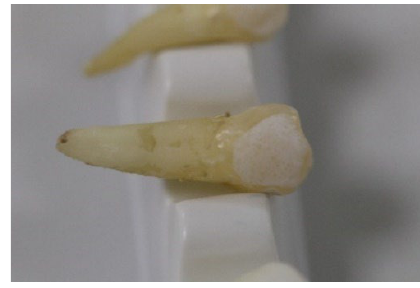
Figure 2. Etched premolars. Table 1. Artificial saliva components.